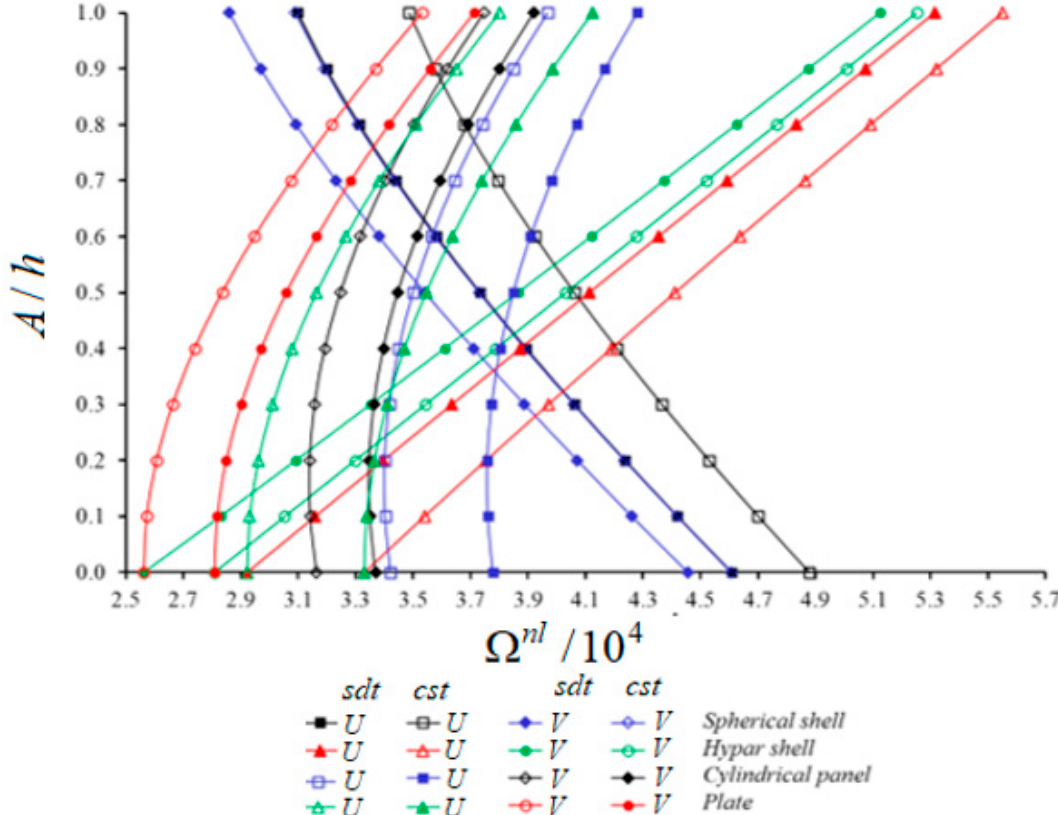
Figure 4. Variation of NLFVs for spherical shell, hypar shell, cylindrical panel and plate patterned by CNTs within CST and SDT against the A / h .